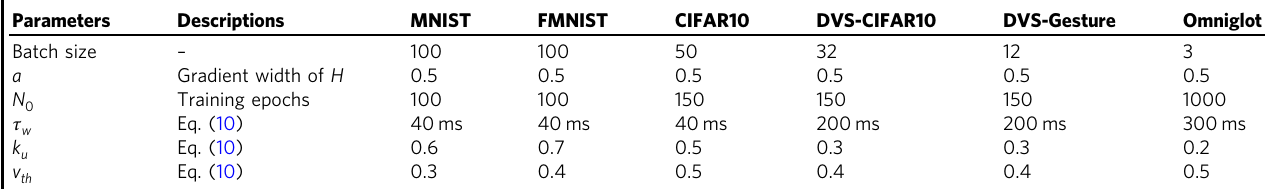
Table 3 Parameter settings on different learning